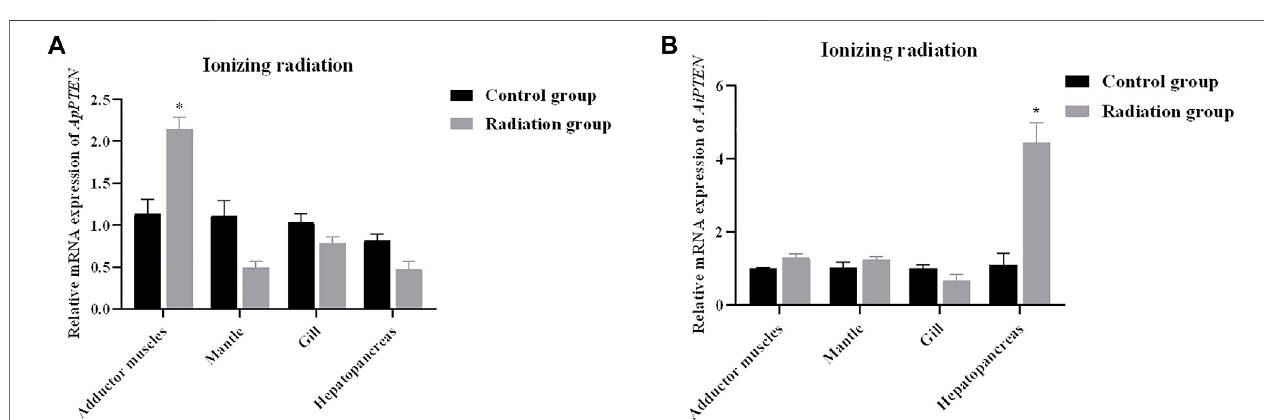
FIGURE 9 | Relative mRNA expressions of ApPTEN (A) and AiPTEN (B) after ionizing radiation (* p < 0.05).